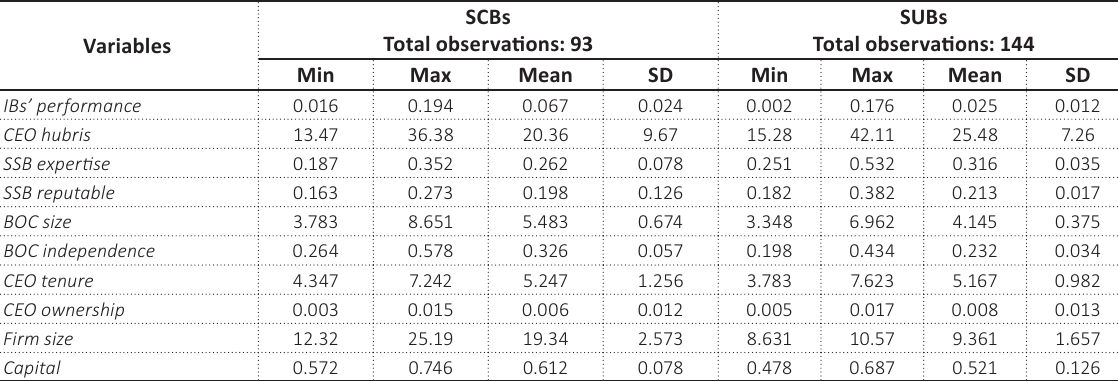
Table 3. Descriptive statistics of variables